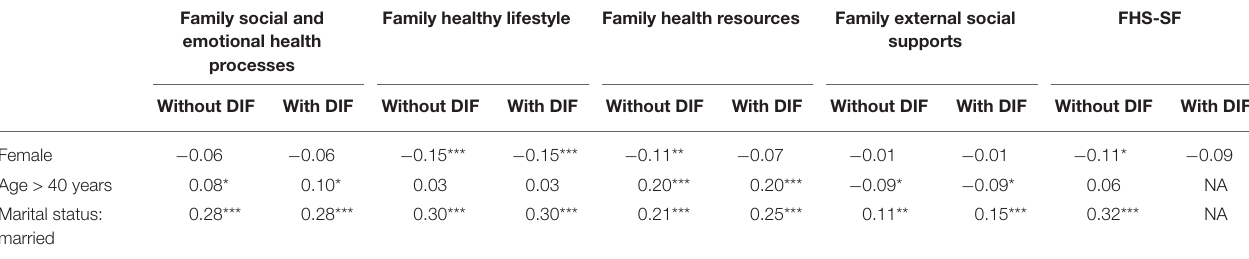
TABLE 6 | Demographic factors and family health, with and without controlling for uniform DIF, n =